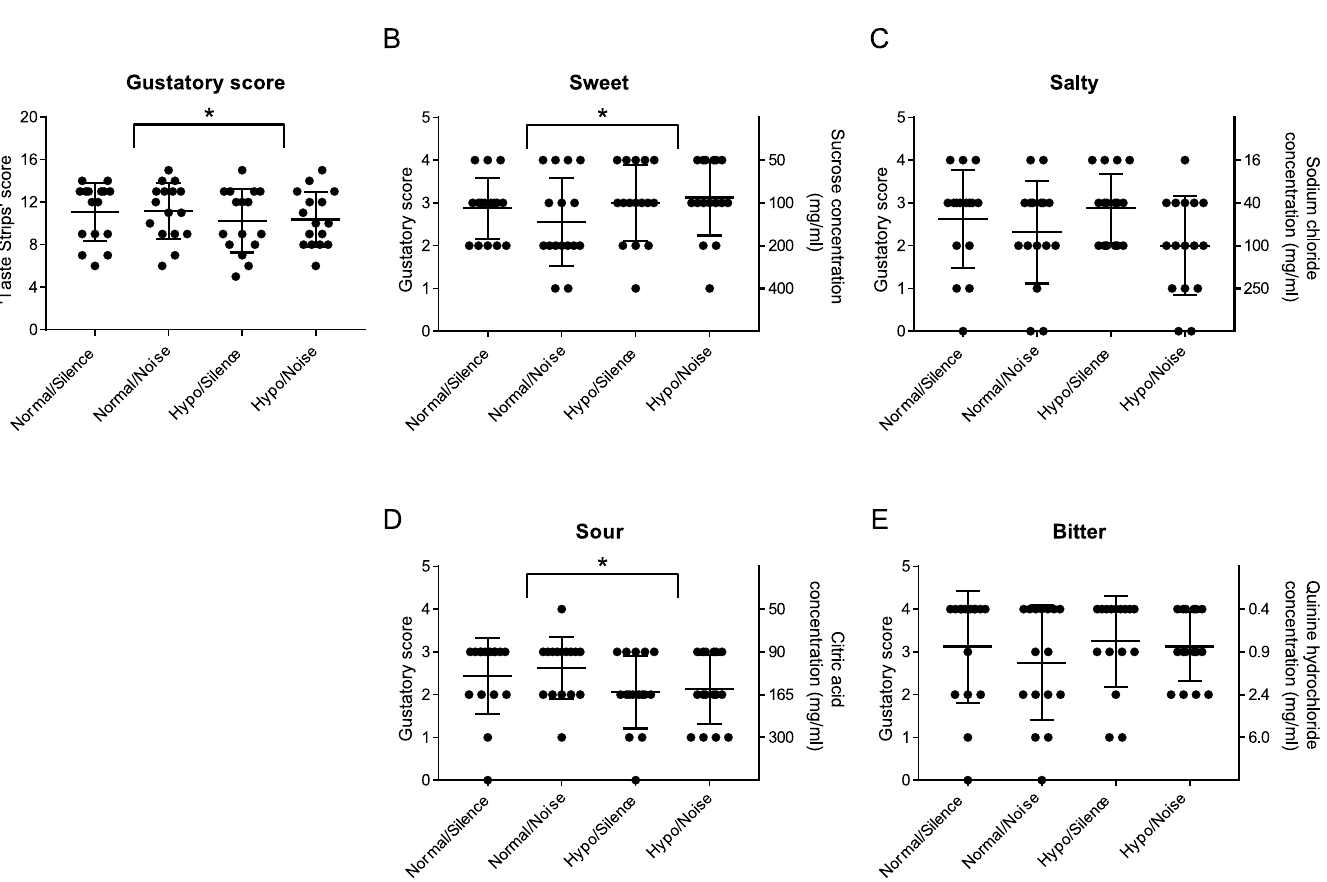
Fig 2. Gustatory score and underlying tastant thresholds for all participants. (A) Individual and mean ( ± SD) cumulative function scores based on ‘Taste Strips’ identification. (B–E) The underlying thresholds for the different tastants as well as the corresponding tastant concentration are also shown. (cid:3) Significant differences at p < 0.05